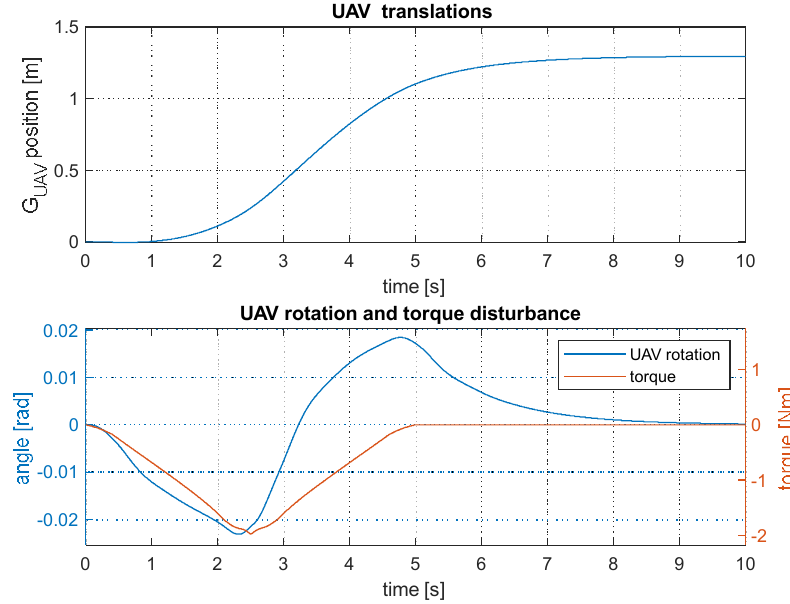
Figure 8. UAV horizontal translation ( top ) and rotation/torque disturbance ( bottom ) during the linear trajectory task for the 2-DOF trolley model with PID control assumption.